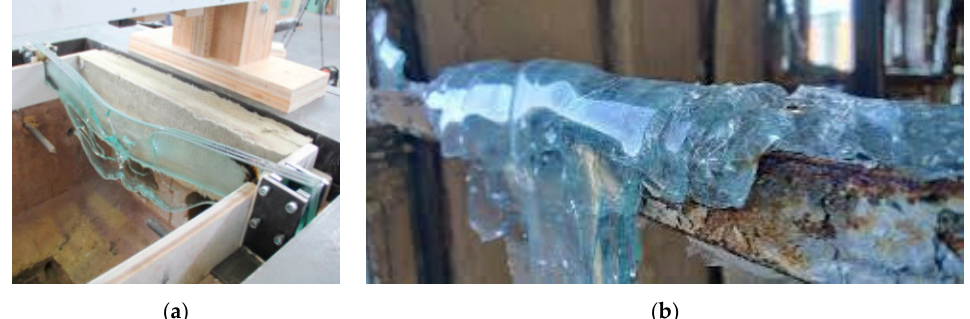
Figure 7. Example of collapse configuration for glass under fire: ( a ) triple-laminated glass beam in bending setup (figure reproduced from [67] with permission from Elsevier©, copyright license agreement n. 5507161319839, March 2023) and ( b ) details of glass softening in the frame region.